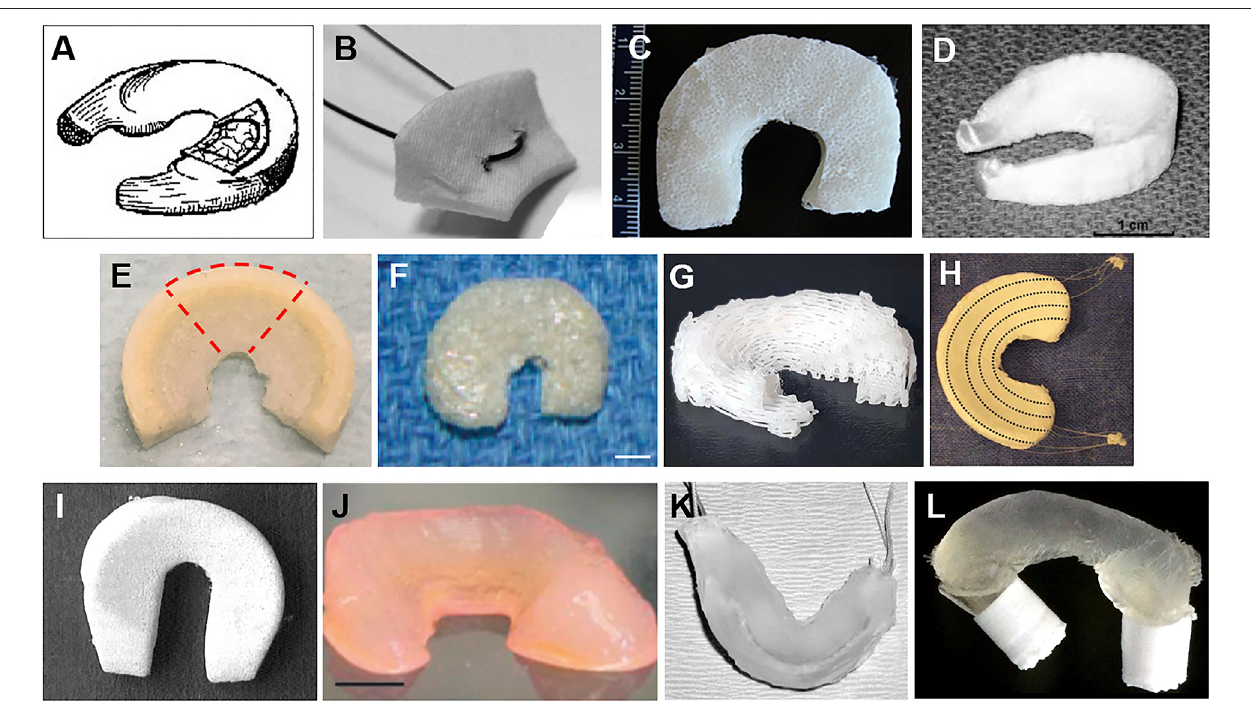
FIGURE 3 | Different kinds of meniscus scaffolds. (A) The SIS meniscal implant (Cook et al., 2006) was used in a dog model. (B) The collagen meniscal implant (Gwinner et al., 2017) was sectioned radially, creating specimens of 15 mm width to measure its biomechanical properties. (C) Multiporous silk scaffold composing of three individual layers with different pore sizes and orientations in each layer (Mandal et al., 2011). (D) Fiber-weaved meniscus scaffold from bovine dermal collagen reinforced by a network of degradable tyrosine-derived polymer fi bers (Balint et al., 2012). (E) The 3D-printed polymer network infusing with collagen – hyaluronic acid(Ghodbaneetal.,2019b). (F) Meniscus-shapedPGAmeshscaffoldofarabbitmodel(scalebar:4 mm)(Kangetal.,2006). (G) A3D-printedPCLmeniscusscaffolds with a biomimetic fi ber architecture (Szojka et al., 2017). (H) A porous scaffold composited of PCL and HYAFF ® and augmented with circumferential PLA fi bers (Chiari et al., 2006). (I) A meniscus scaffold fabricated by PCLPU for a dog model (Welsing et al., 2008). (J) Anatomically shaped alginate meniscus (scale bar: 5 mm) (Puetzer et al., 2013). (K) Hydrogel meniscal construct with sutures woven through the anterior and posterior horn used in a sheep model (Kelly et al., 2007). (L) Thermoplastic elastomer (TPE) hydrogel with tabs swollen into PLA cylinders (Fischenich et al., 2018).